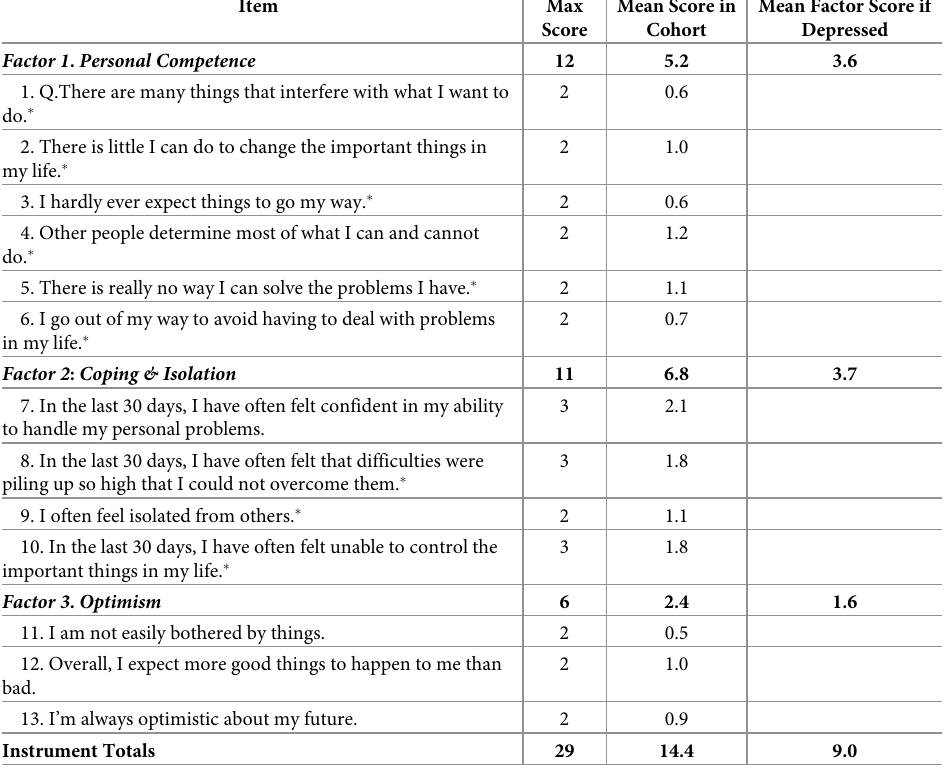
Table 3. Add Health Resilience